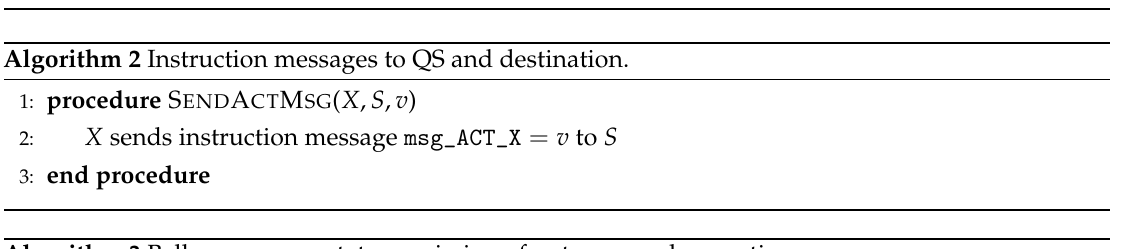
Algorithm 3 Bell measurement, transmission of outcome and correction.